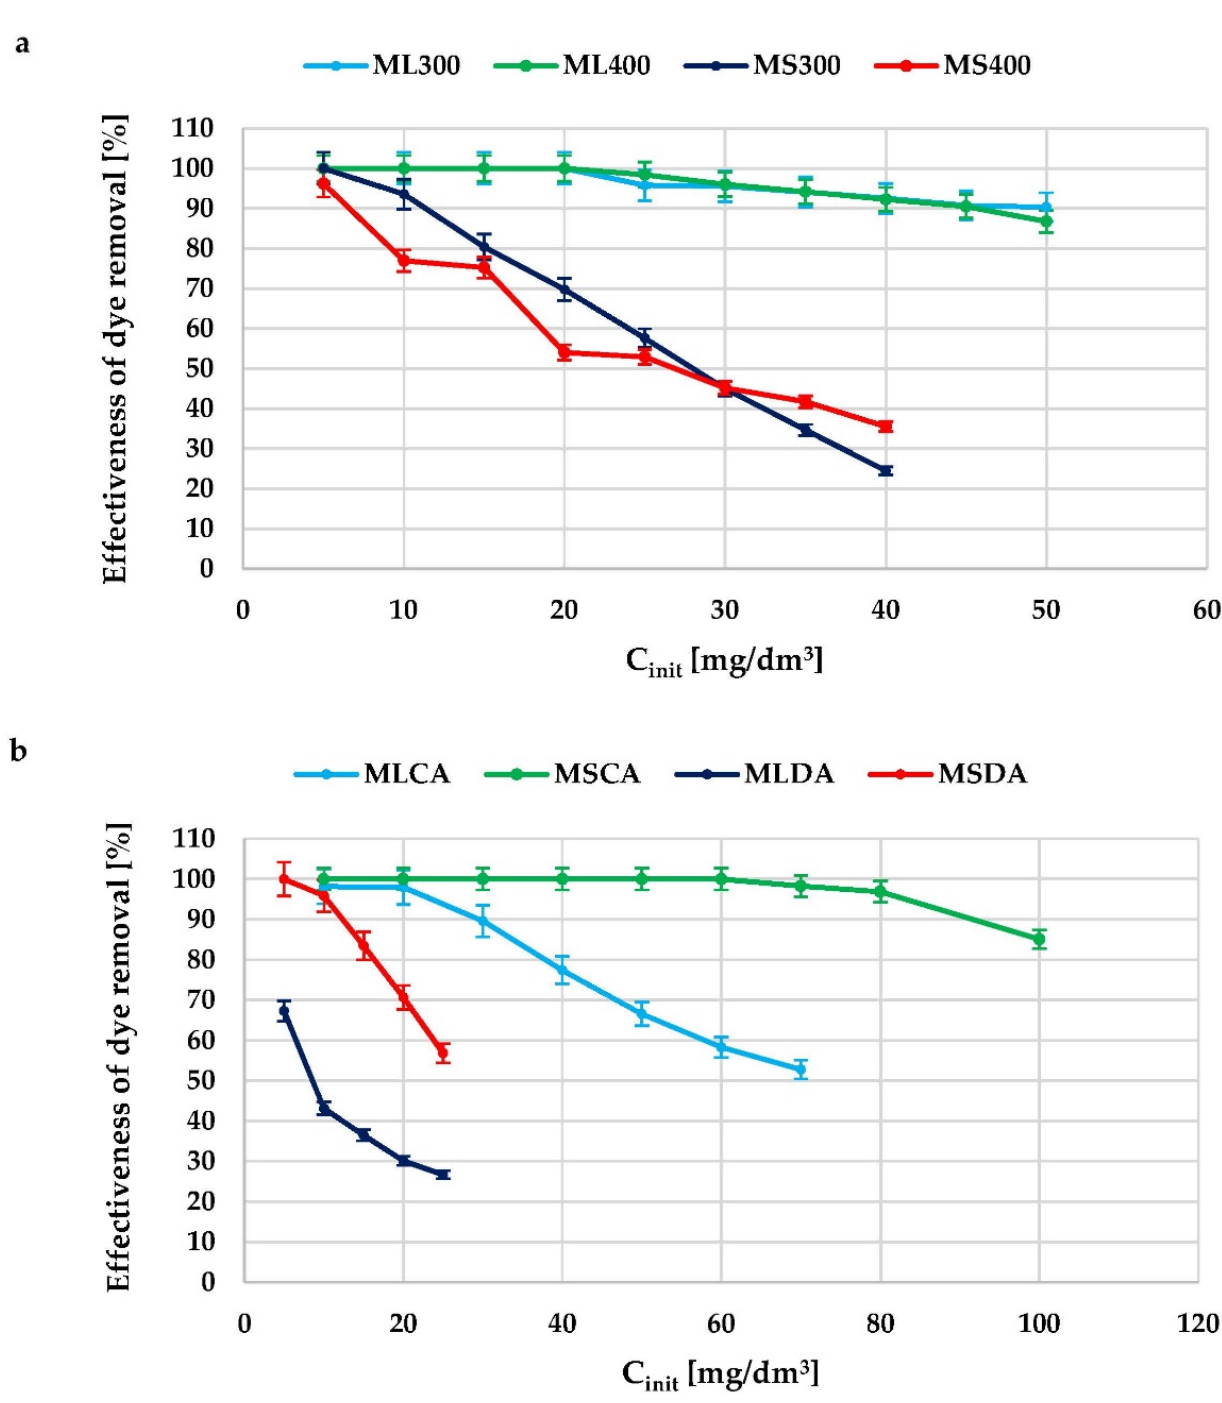
Figure 5. The effectiveness of methylene blue removal from aqueous solutions for the biochars ( a ) and activated biocarbons ( b ) prepared from mugwort post-extraction residue. Table 4. Langmuir, Freundlich and Temkin parameters of the isotherms of methylene blue adsorp- tion on the biochars prepared from mugwort post-extraction residue.